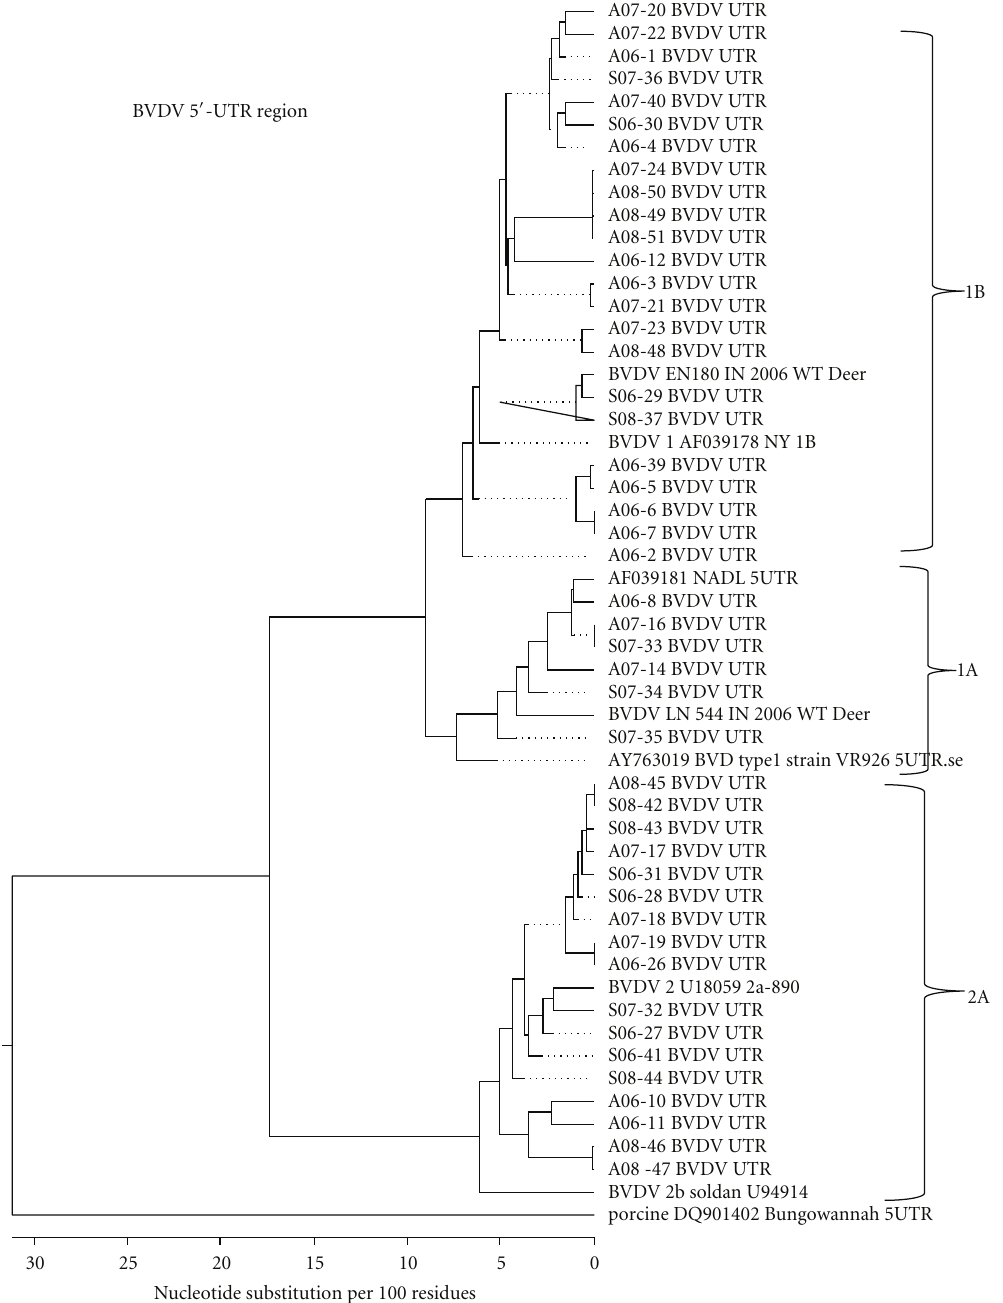
Figure 1: Phylogenetic tree of pestiviruses sequenced at 5 (cid:2) -UTR from cattle isolate samples submitted to the Indiana Animal Disease Diagnostic Laboratory between 2006 and 2008 compared to reference BVD viruses constructed by DNASTAR program, using Clustal W